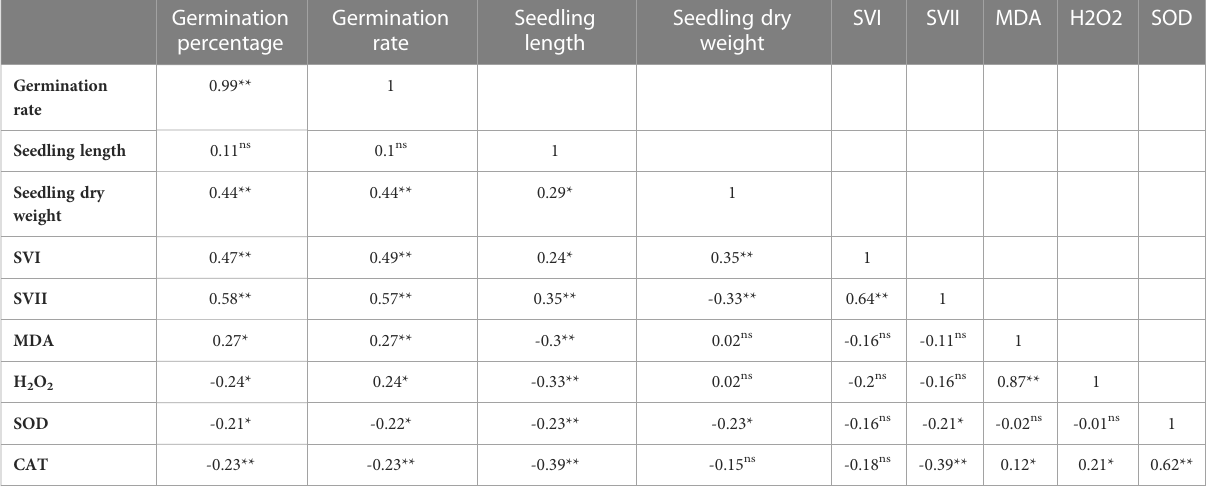
TABLE 4 Pearson correlation matrix for morphological, biochemical, and antioxidant enzyme activity in normal and uncovered S. leriifolia seeds under cold plasma treatment (80 and 100 W with an exposure time of 0, 120, 180, and 240 s) and hydropriming.